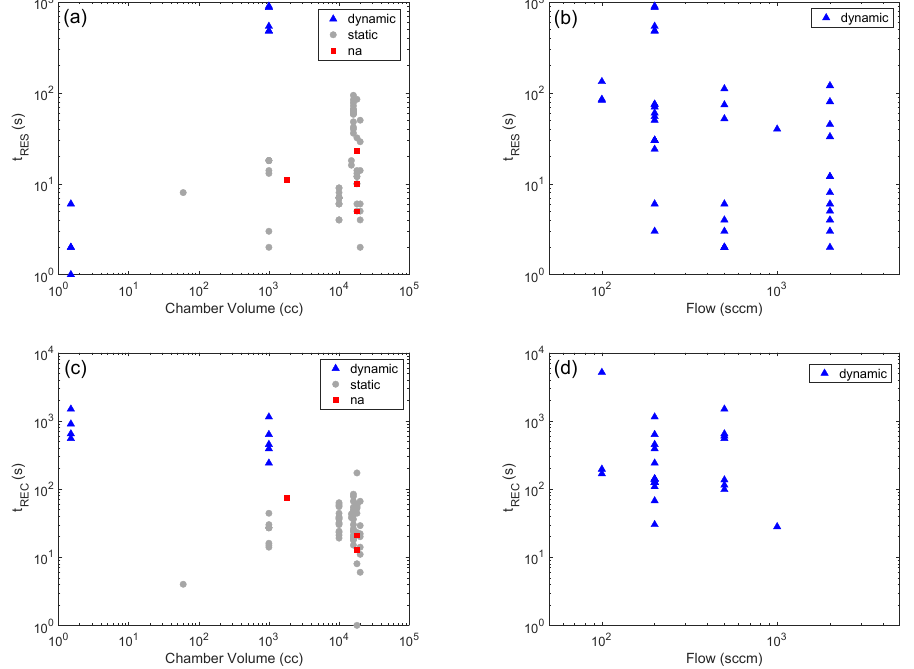
Figure A2. Test chamber volume, flow and measurement setup effects on the response (t RES ) and recovery (t REC ) times. Plots are t RES vs chamber volume ( a ), t RES vs flow ( b ), t REC vs chamber volume ( c ) and t REC vs flow ( d ). In all plots, colors are used to distinguish different measurement setups, and ‘na’ stands for ‘not available’.